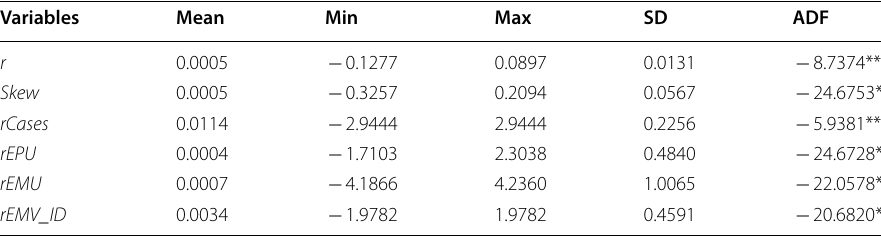
Table 2 Descriptive statistics